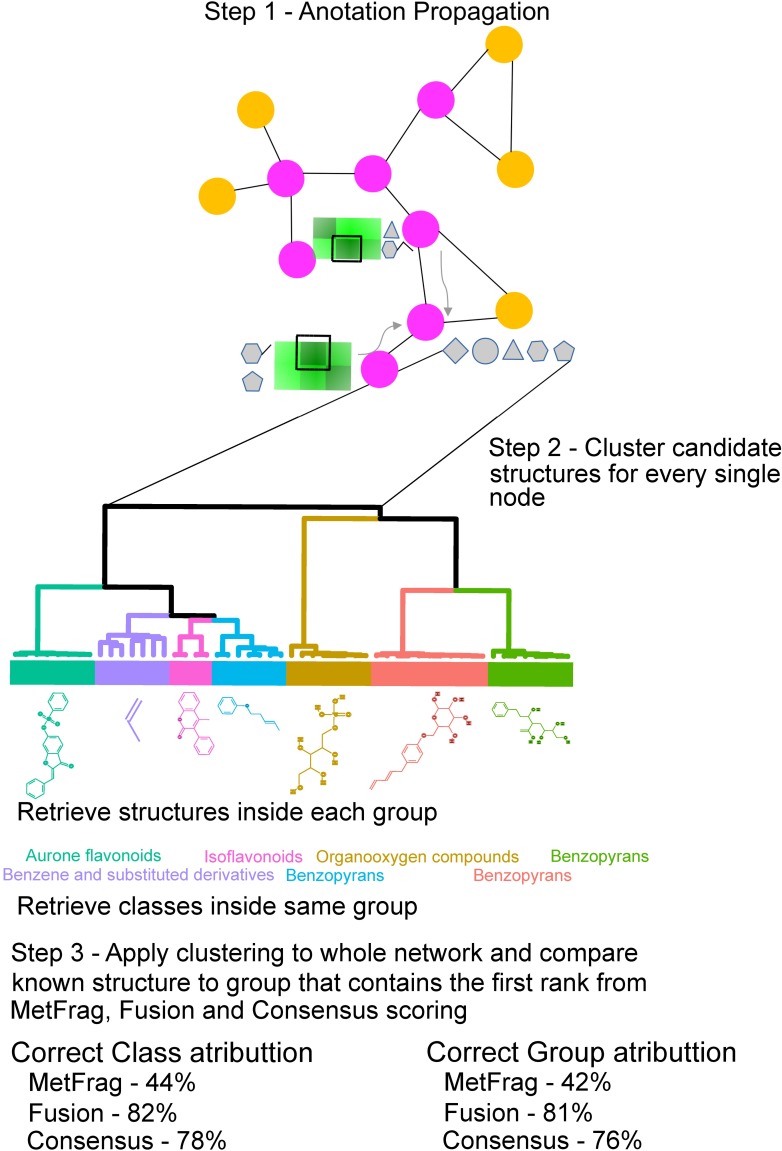
Schematic representation of the molecular structure candidates clustering by structural similarity and dynamic cluster assignment from the 5467 NIST17 [M+H]+ unique compound spectra with ClassyFire chemical taxonomy.The structurally related group of candidate structures, detected by unsupervised clustering, containing the first candidates ranked by network Fusion and network Consensus often contains the maximum common substructure shared between in silico candidates (for candidates inside the group defined by clustering) and the known structure in the validation dataset (numbers shown in the bottom). The structurally related groups are highlighted by colors, inside each group we also show class assignments. The classes/structures that were predicted by unsupervised clustering were compared with the known compound.